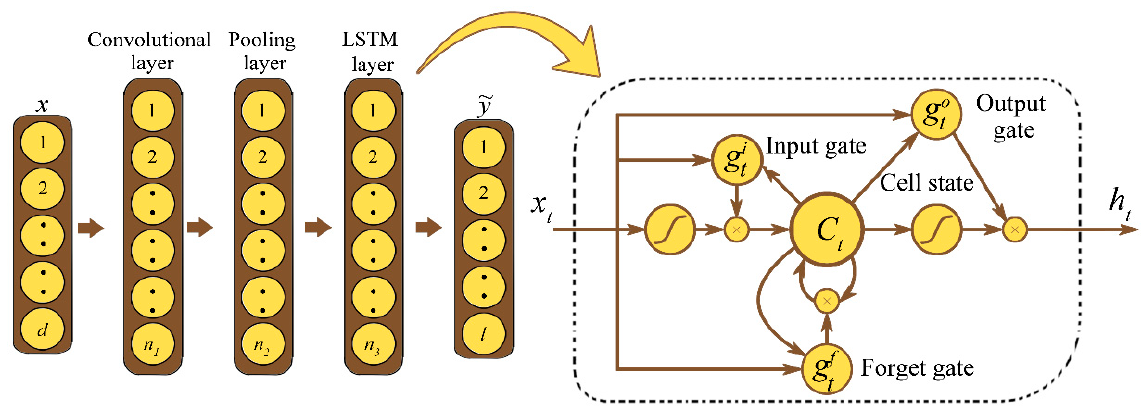
Figure 10. Data-driven approach for both learning and knowledge transfer. LSTM, long–short-term memory.